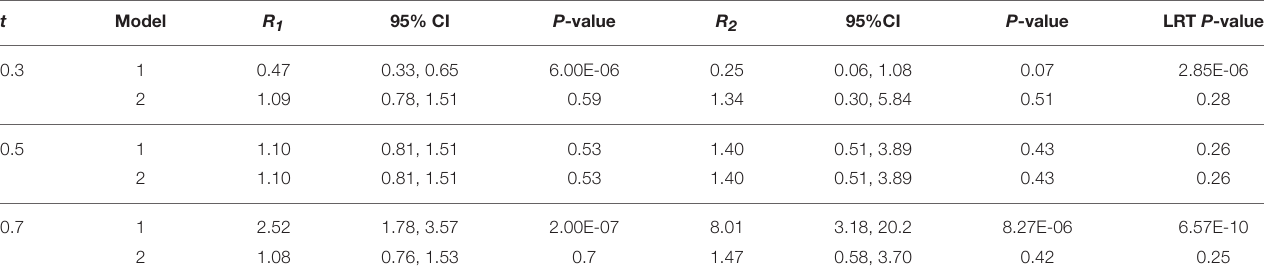
TABLE 2 | Relative risk with 95% CI, P -values, and likelihood ratio test P -values of models 1 (Unadjusted) and 2 (Adjusted) for a low penetrance common disease. t Model